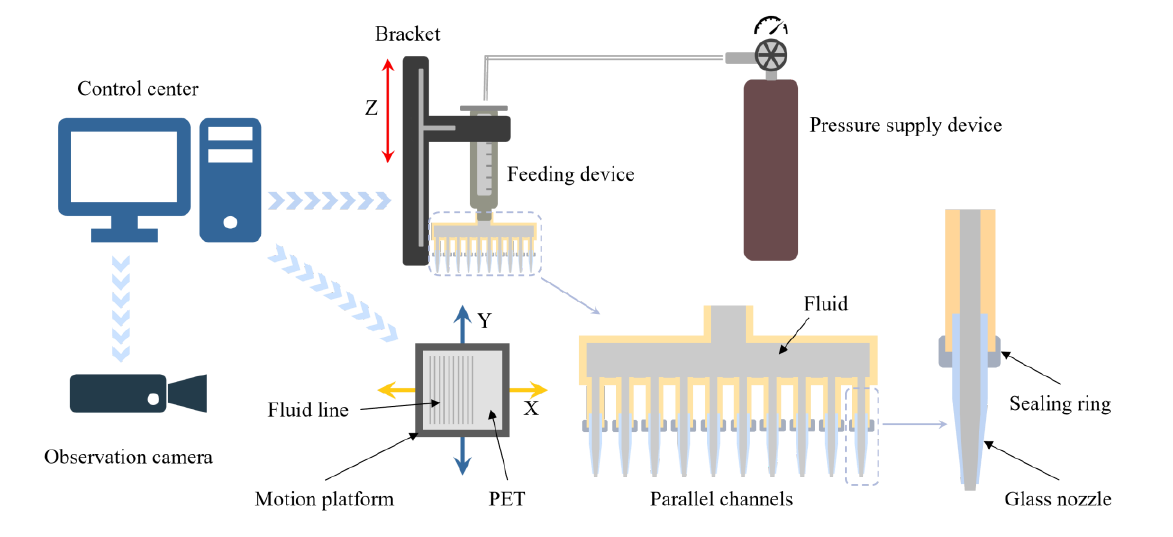
Figure 12. The experimental equipment of this study.